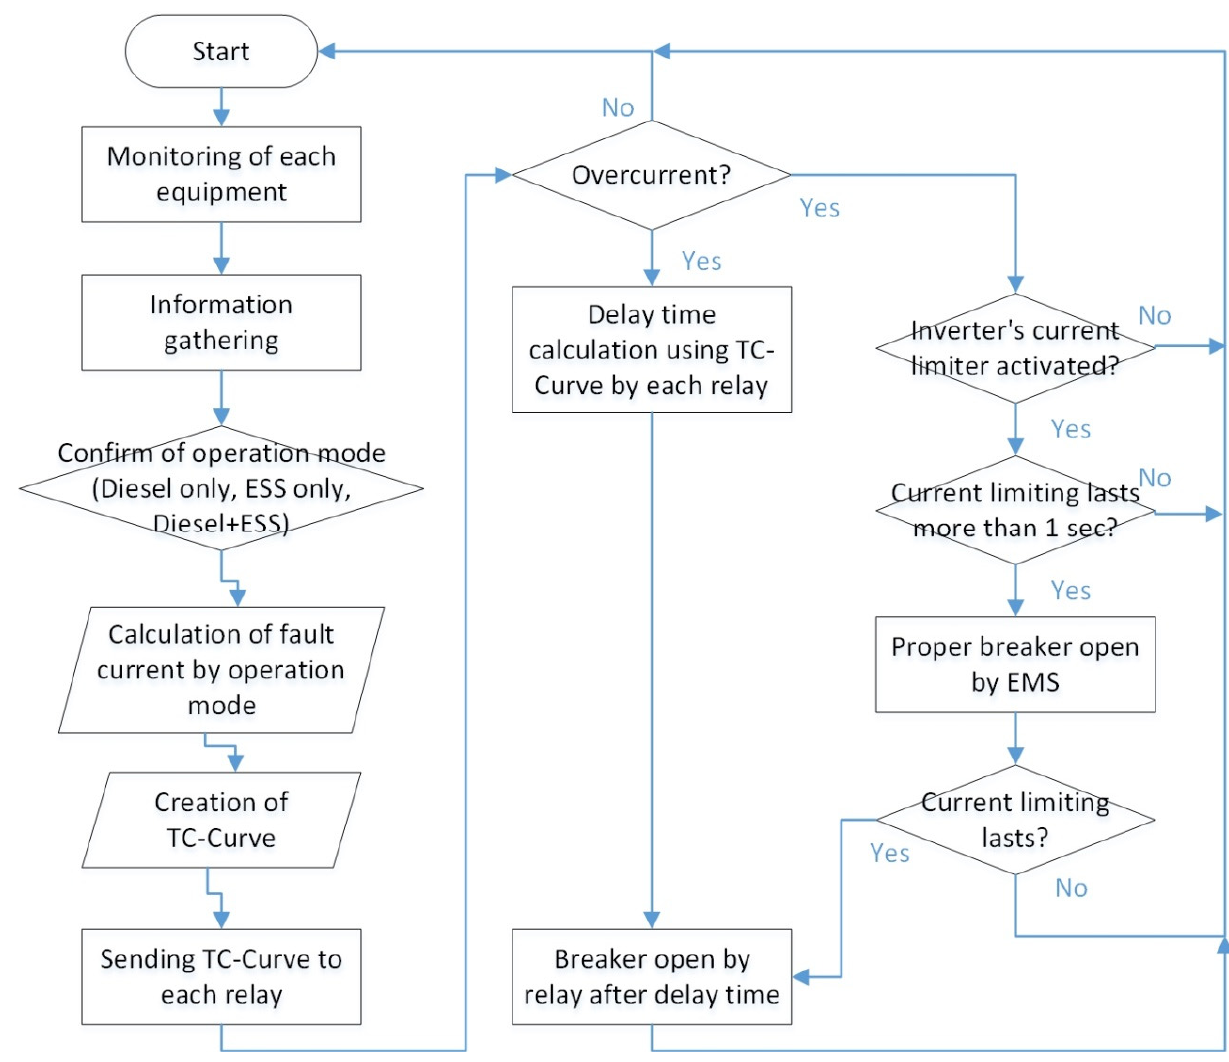
Figure 4. Overall process of adaptive protection algorithm.